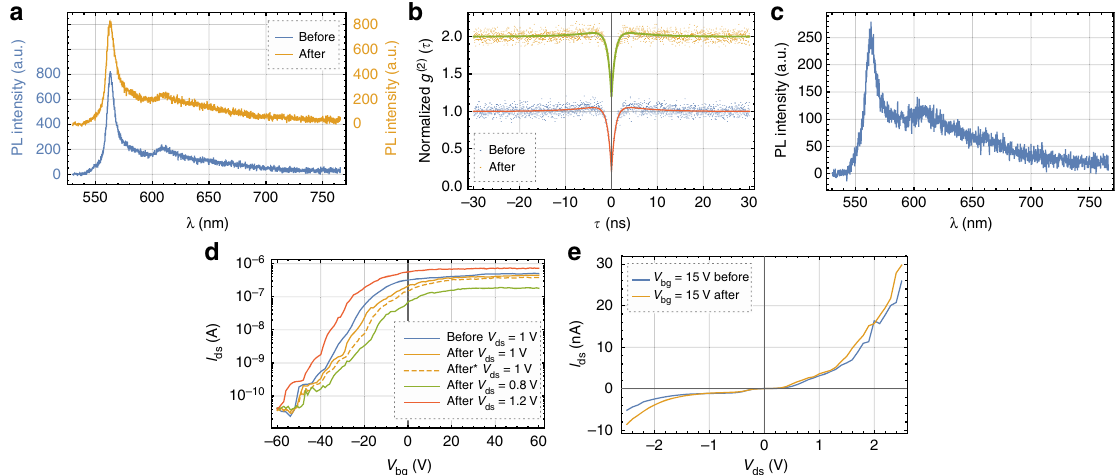
Fig. 3 γ -Ray tests of two-dimensional material-based devices. a Photoluminescence spectra of an hexagonal boron nitride quantum emitter before and after the γ -ray tests show no changes (vertically offset for clarity). b Second-order correlation function dipping at zero time delay to 0.185(23) before and to 0.188(25) after the irradiation. The values were obtained from fi tting a three-level system (for clarity, the fi ts are differently colored). c Spectrum of a newly created quantum emitter after the γ -ray test. As the emitter was not annealed following the irradiation, its brightness and stability was lacking behind plasma-etched and annealed emitters. d Back gate sweeps before and after the irradiation with different drain-source biases V ds . The orange dashed line was recorded 5 h past the orange solid line to check for temporal variations. In terms of current ON/OFF ratio, the temporal variations are larger than the variations caused by the γ -rays. Tuning the V ds can restore the initial performance (see area between green and red lines). e The I – V curve at a fi xed V bg = 15 V shows only slight alteration after irradiation. The shift of the threshold voltage is <0.1